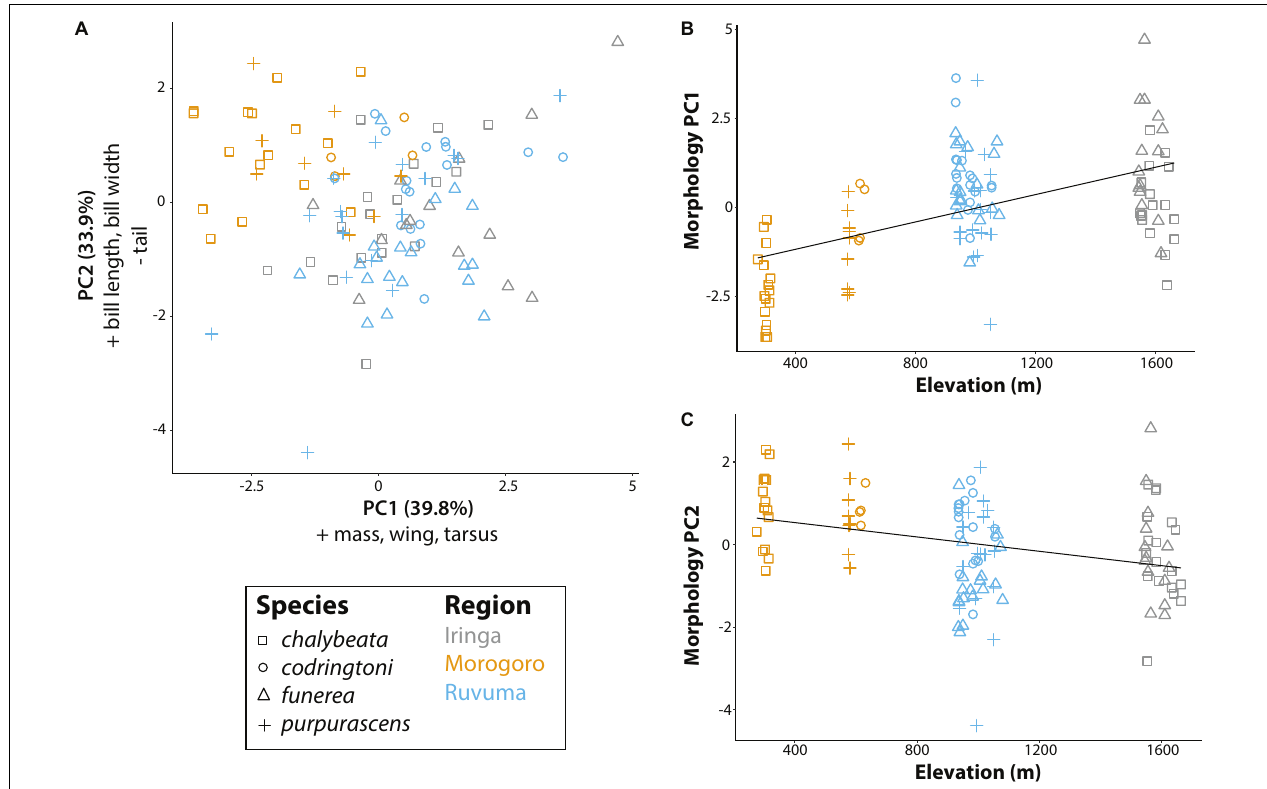
FIGURE 3 | Morphological variation of male indigobirds relative to elevation of their call sites. (A) The first two principal components of a PCA including measurements of mass, wing length, tail length, tarsus length, bill length, bill width, and bill depth. Variables with loadings > 0.4 ( + ) or < − 0.4 ( − ) for each component are reported in the corresponding axis label. (B,C) Linear regressions for each of the first two morphology principal components with elevation as the explanatory variable. Lines show the least square regression line. Symbols and colors are used to denote different species and regions,